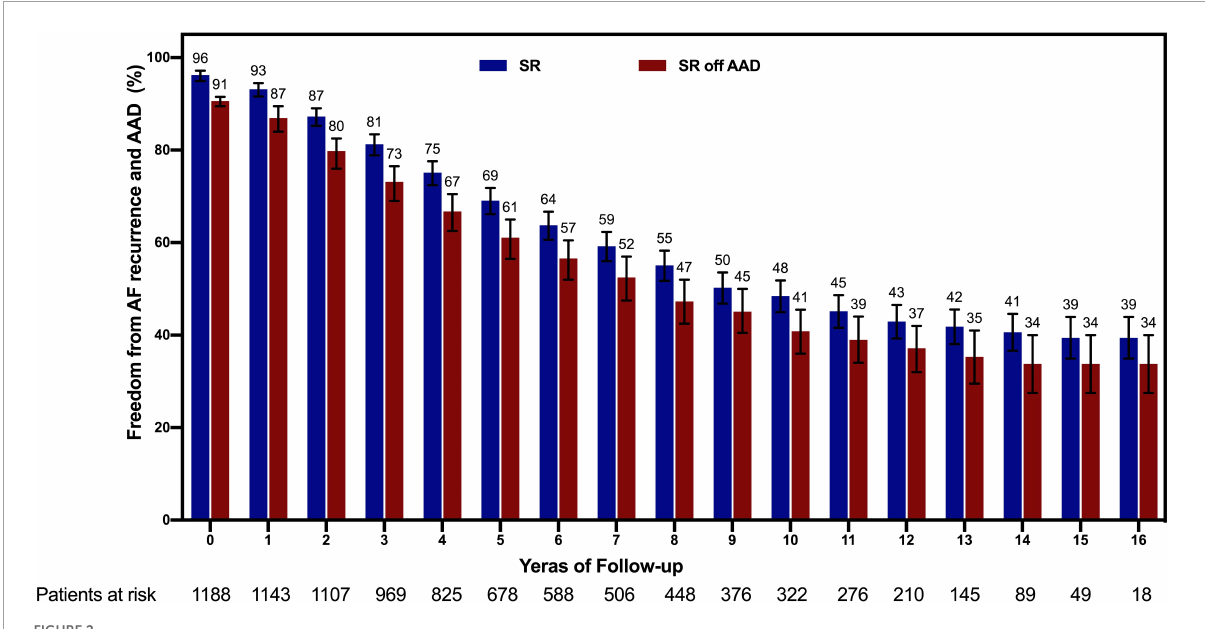
FIGURE2 Follow-up showing freedom from recurrence of AF both on and off AADs with 95% confidence intervals. AF, atrial fibrillation; AAD, antiarrhythmic drug; SR, sinus rhythm.